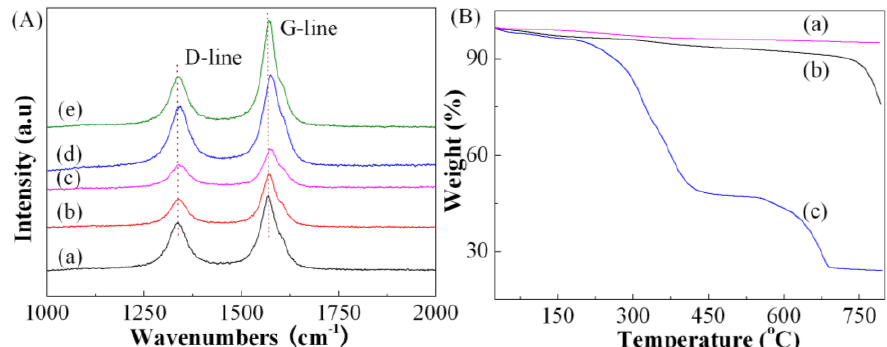
Figure 2. Raman spectra (A) of (a) MWCNTs, (b) MWCNTs@ZnO nanocomposite and (c–e) MWCNTs@ZnO/PMAEFc with various PMAEFc mass percentages (%): (c) 25; (d) 50 and (e) 75; and TGA traces (B) of (a) MWCNTs, (b) MWCNTs@ZnO nanocomposite and (c) MWCNTs@ZnO/PMAEFc with PMAEFc mass percentages of 25%.